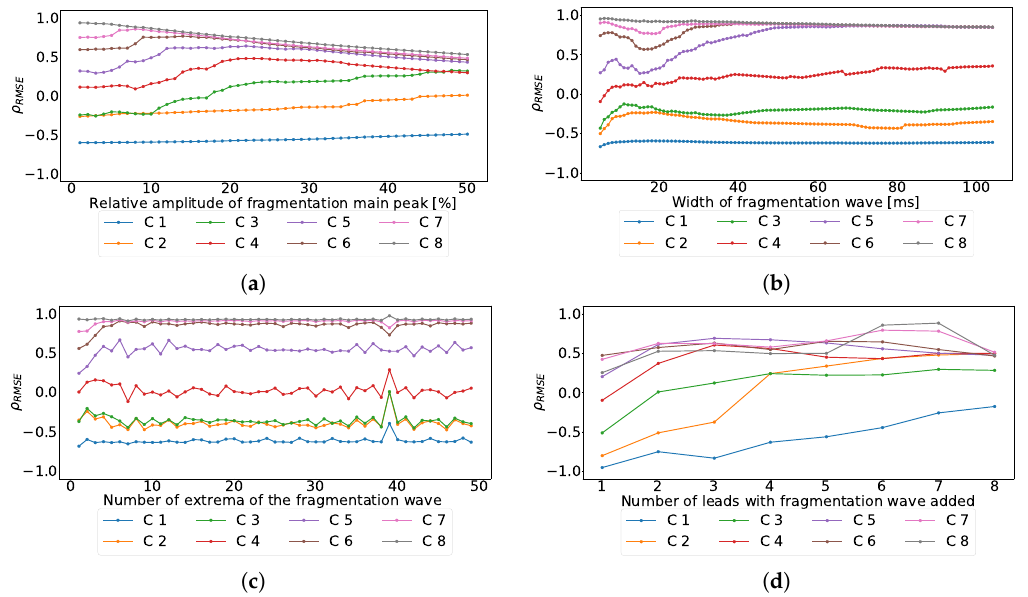
Figure 6. Effect of the different parameters of the subrogated fragmented wave over the ρ RMSE coefficient for independent-lead PCA model. Values lower than 0 correspond with RMSE higher in the ECG than in the principal components, values higher than 0 correspond with RMSE higher in principal components than in the ECG. ( a ) Effect of the fragmented wave amplitude, ( b ) effect of the fragmented wave width, ( c ) effect of the cycle number of fragmented waves, and ( d ) effect of the number of affected leads. The last set of PCA experiments was created to try out the enhancement in fragmentation detection through heart-region projections . According wto medical knowledge, the ECG leads can be divided in